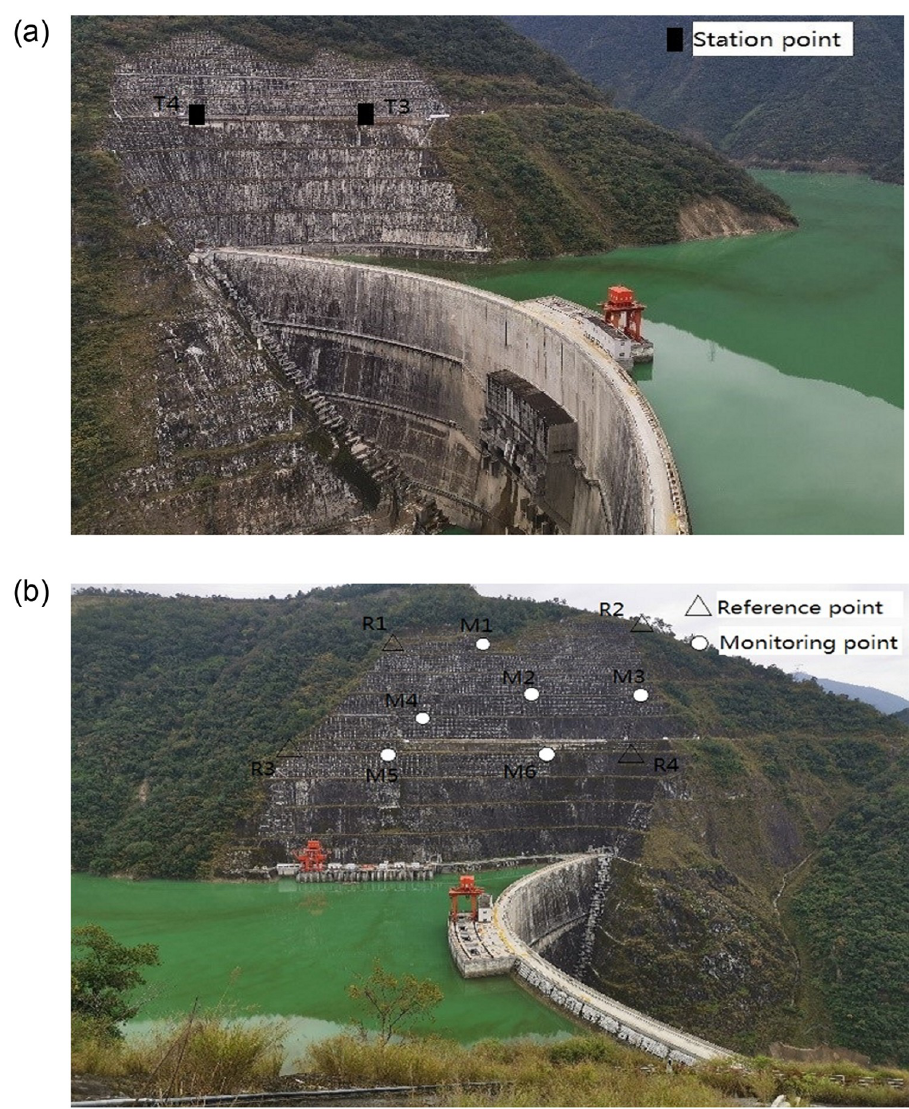
Fig 9. Refraction correction test in Dagangshan hydropower station. (a) Station point on the right bank. (b) Reference/monitoring points on the left bank.